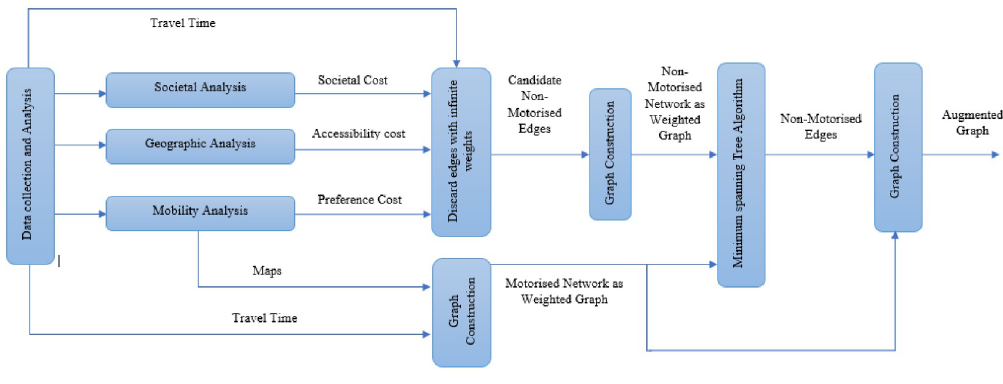
Fig 3. Flowchart of the proposed